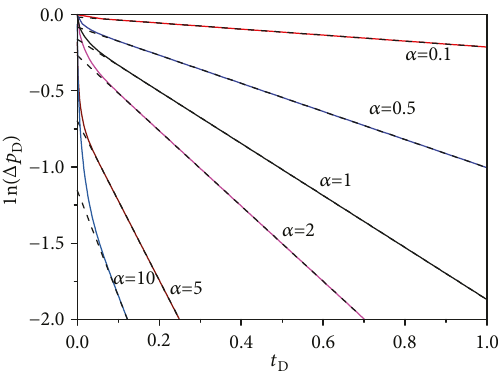
Figure 1: A comparison of the general solution (equation (6), the solid curves) with the fi rst term of equation (6) (the dashed curves) for di ff erent ratios of pore volume to chamber volume (assuming the volume of upstream chamber equals to that of the downstream chamber, i.e., a = b ).